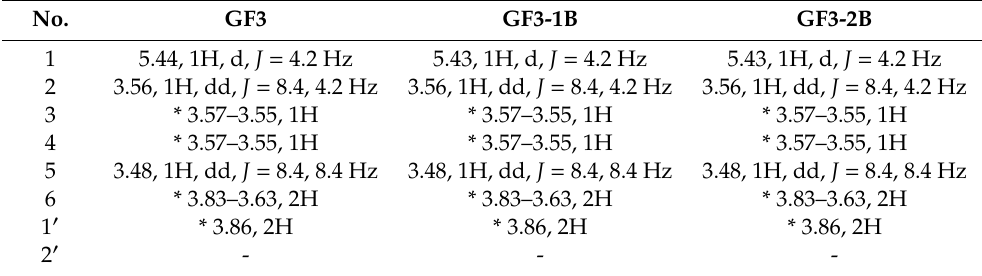
Table 1. 1 H-NMR data of fructooligosaccharide (GF3) and butyl-fructooligosaccharides (GF3-1B and GF3-2B) ( δ H in ppm).